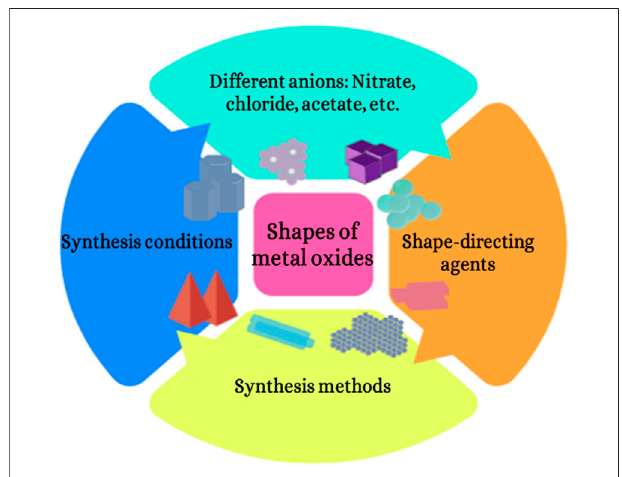
FIGURE 2 | Effect of synthesis conditions on the morphologies of metal